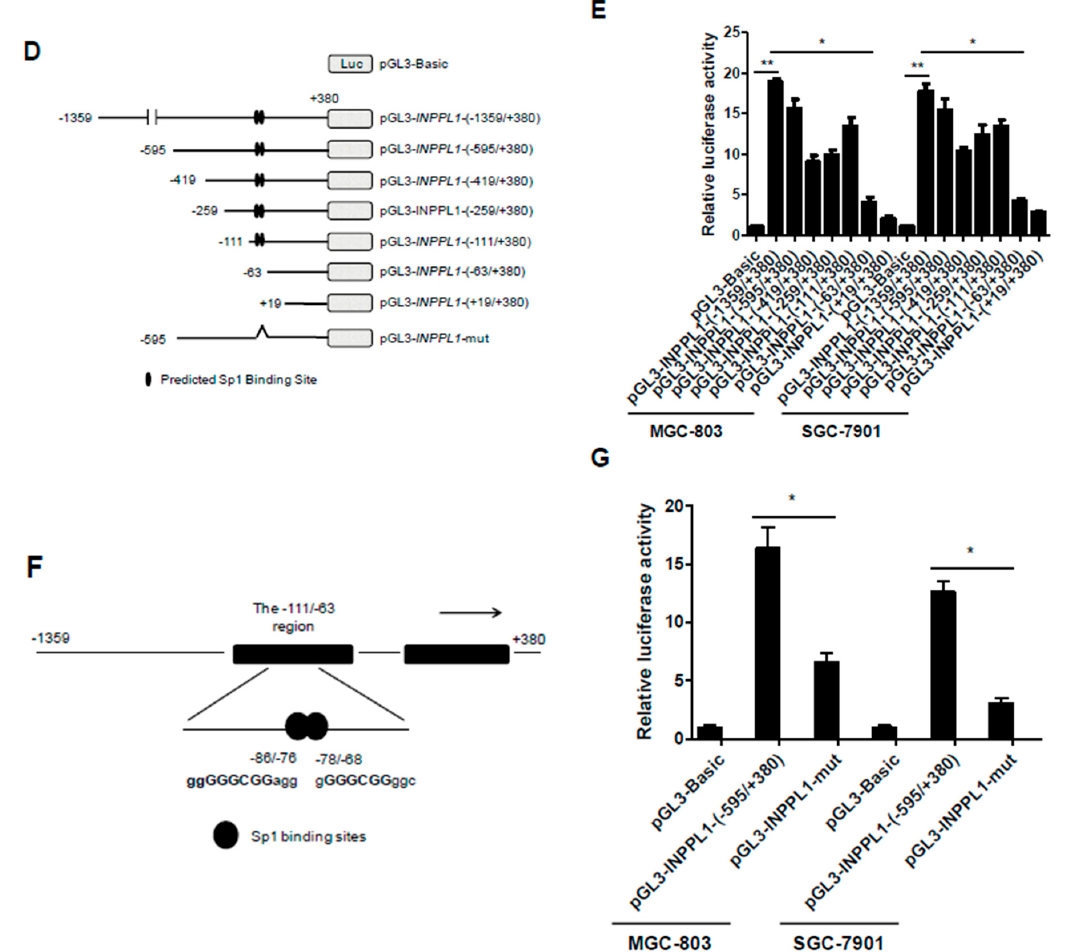
Figure 1. SHIP2 is regulated by transcription factor Sp1 in GC cells. ( A ) Copy number variation of INPPL1 in the normal gastric mucosa epithelial cells GES-1 and a panel of GC cells as quantitated by qPCR analysis of genomic DNA. ( n = 3, mean ± SEM); ( B ) whole cell lysates from GES-1 and a panel of GC cells treated with 5-aza-dC (10 μ M) for 96 h or SAHA (5 μ M) for 24 h were subjected to Western blot analysis. Data shown are representative of 3 individual experiments; ( C ) a typical CpG island is present at the promoter region of SHIP2. Each vertical bar represents a single CpG site. The transcription start site (TSS) is indicated by a curved arrow. BGS analysis showed no/low promoter methylation in a panel of GC cells; ( D ) a schematic illustration of construction of the luciferase reporter constructs containing a series of 5 ′ -truncted INPPL1 promoters and the Sp1-binding site deletion mutant; ( E ) MGC-803 and SGC-7901 cells were transiently co-transfected with pRL-TK plasmid and the pGL3-basic vector, pGL3- INPPL1 -( − 1359/+380) construct and a series of 5 -deletion mutants of pGL3- INPPL1 -( − 1359/+380). Luciferase activity was determined 48 h later, and the value was normalized to that of pGL3-basic vector designated as 1 ( n = 3, mean ± SEM, * p < 0.05 vs. pGL3- INPPL1 -( − 63/+380), ** p < 0.01); ( F ) a schematic illustration of the Sp1 binding site-enriched fragment ( − 86/ − 68) in the − 111/ − 63 region of the INPPL1 promoter; ( G ) MGC-803 and SGC-7901 cells were transiently co-transfected with pRL-TK plasmid and the pGL3-basic vector, pGL3- INPPL1 -( − 595/+380) construct and pGL3- INPPL1 -mut. Luciferase activity was determined 48 h later, and the value was normalized to that of pGL3-basic vector designated as 1 ( n = 3, mean ± SEM, * p < 0.05).